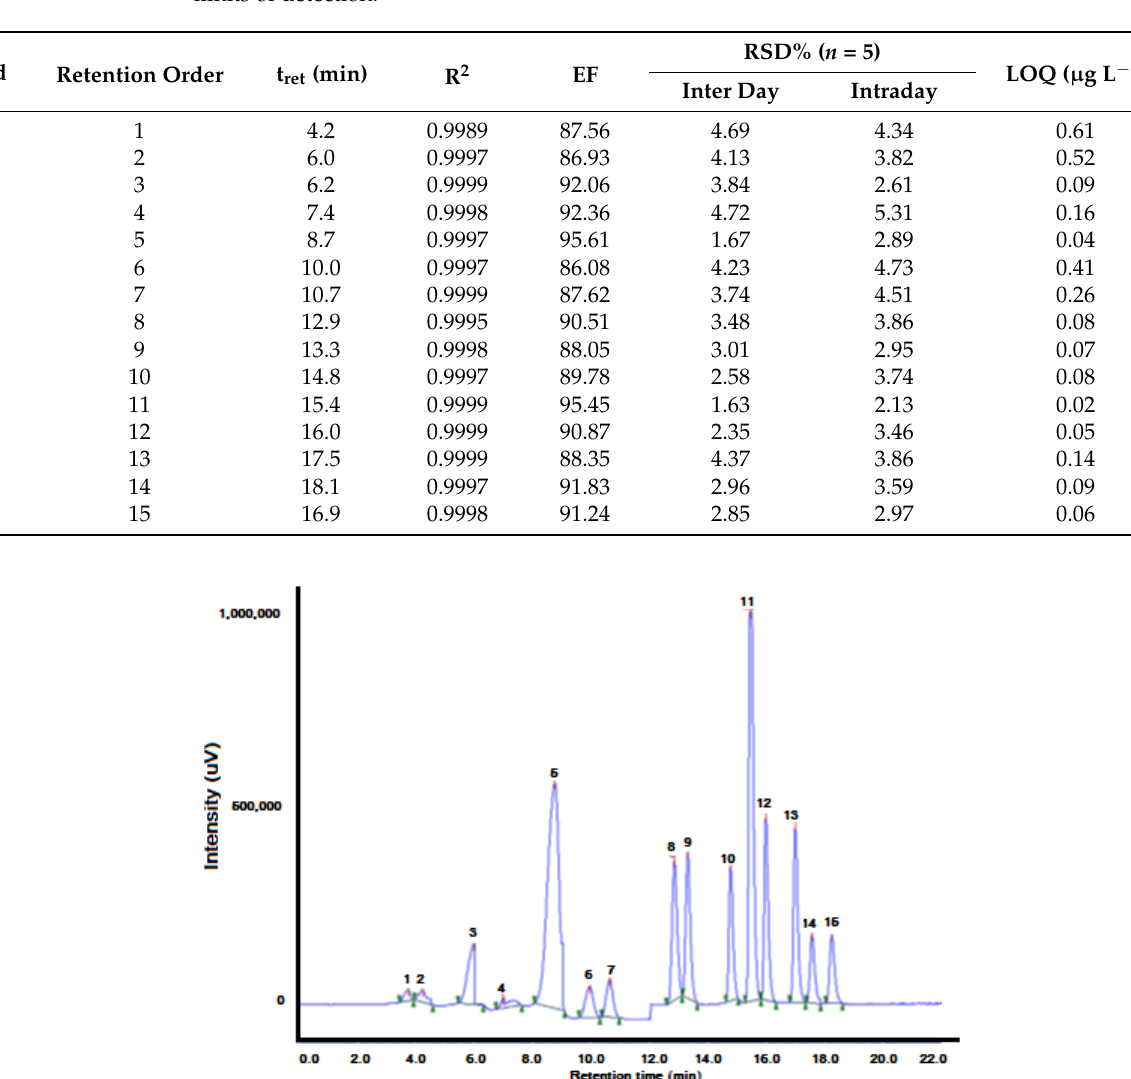
Table 2. Several LIS methods hyphenated with chromatographies.